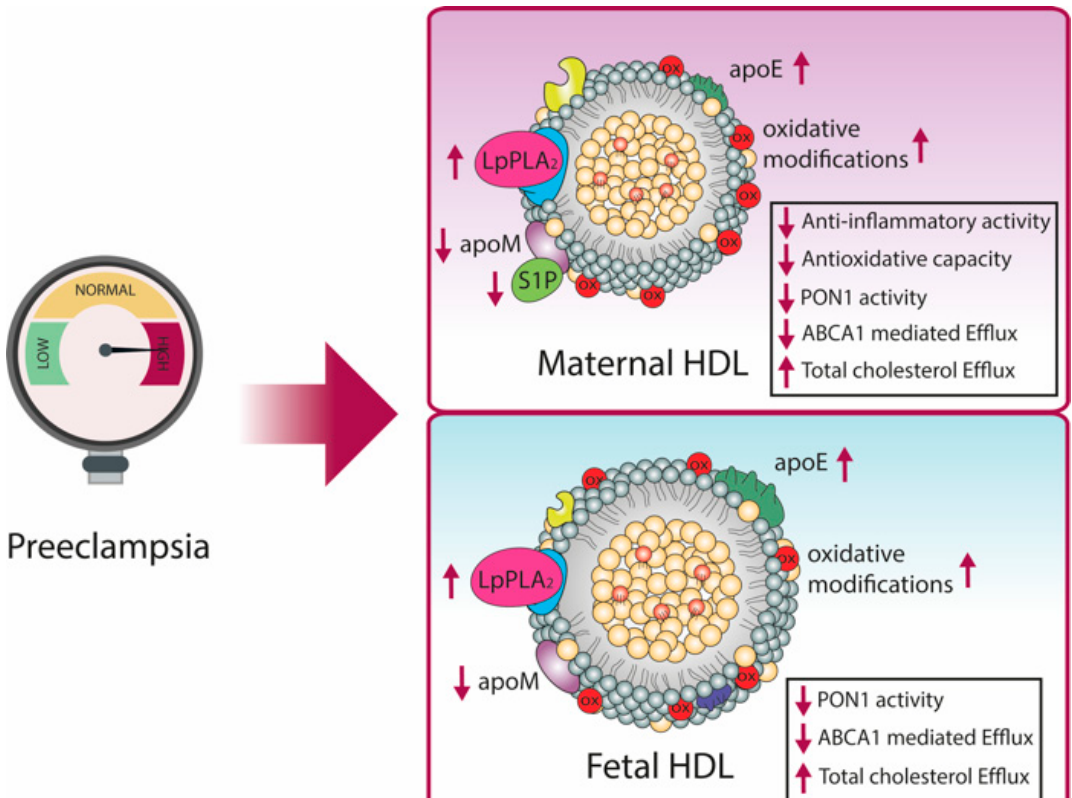
Figure 3. PE affects maternal and fetal HDL composition and function. Changes are indicated with purple arrows. In maternal HDL, a decrease in PON1 activity, apoM, and S1P content was observed, whereas apoE and LpPLA 2 were in ‐ creased. These changes in HDL composition were associated with reduced anti ‐ inflammatory and anti ‐ oxidative activity, but increased cholesterol efflux capacity. Fetal HDL of PE pregnancies showed similar changes, with reduced PON1 ac ‐ tivity and apoM, but increased LpPLA 2 and apoE, accompanied by increased cholesterol efflux capacity. Oxidative mod ‐ ifications of lipids were detected in both maternal and fetal HDL. HDL, high ‐ density lipoprotein; apo, apolipoprotein; PON1, paraoxonase 1; LpPLA 2 , lipoprotein ‐ associated phospholipase A2.